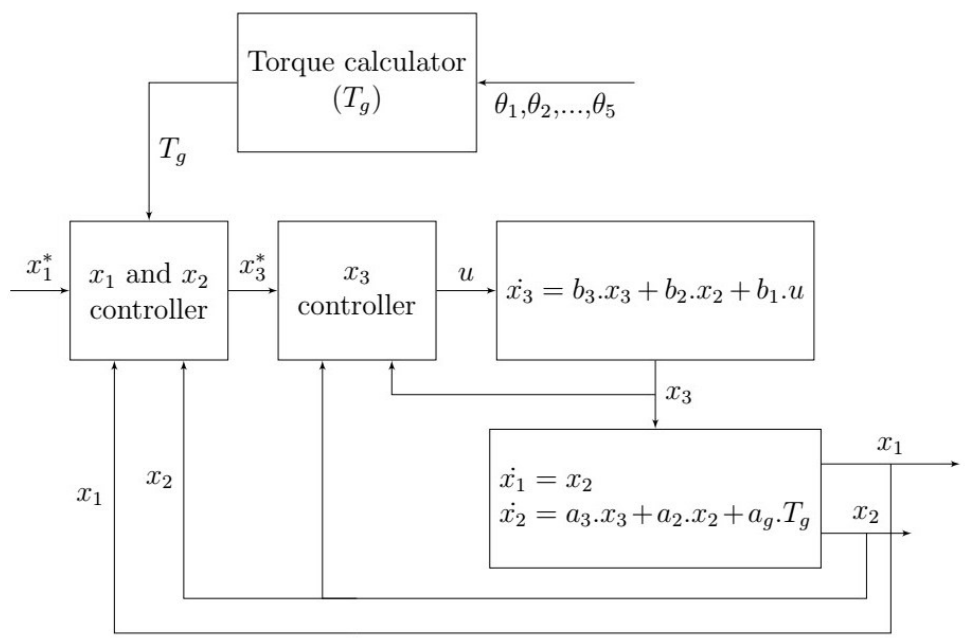
Figure 31. The synoptic diagram of the controller for each